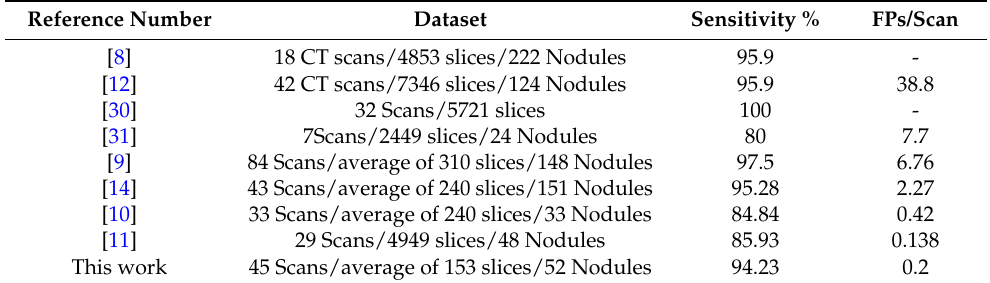
Table 2. Performance comparison of the methodology proposed with other research papers.